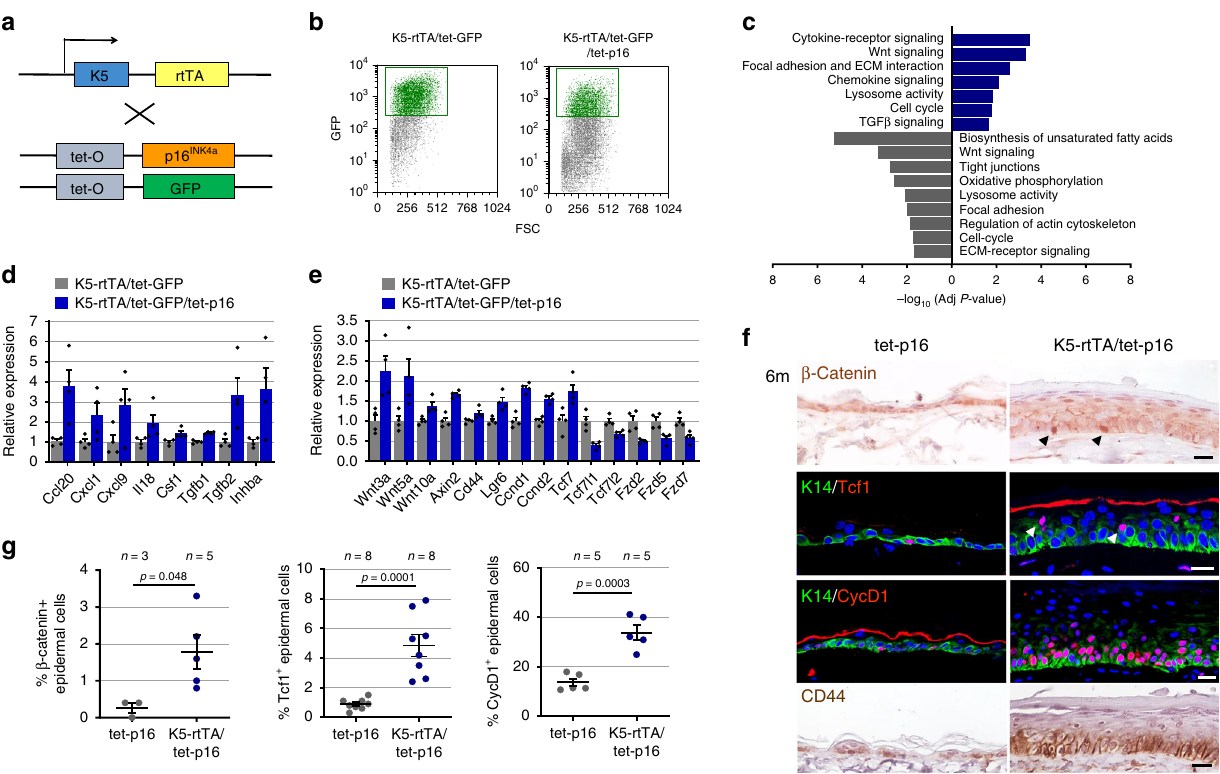
Fig. 4 p16 expression activates Wnt-pathway-associated genes. a Diagram of transgenic mouse lines crossed for co-induction of GFP and p16. b FACS plots showing GFP levels and gates used for isolation of GFP + epidermal cells from K5-rtTA/tet-GFP/tet-p16 (right) and control K5-rtTA/tet-GFP (left) mice, after 6 months of induction. Plots show the CD31 − /CD140a − /CD45 − cell fraction only. c Gene sets whose expression was preferentially upregulated (blue) or downregulated (grey) in GFP + cells from p16-expressing mice relative to GFP + cells from control mice. Values indicate – log 10 (adjusted P value) by hypergeometric test. d mRNA levels of genes encoding cytokines and genes associated with the TGF β pathway upregulated in p16-expressing GFP + cells, measured by mRNA-seq. Values were normalized to the mean expression levels in GFP + cells from control mice, de fi ned as 1. P < 0.05 for all genes, n = 4 samples per group, each pooled from 3 mice. e Relative mRNA levels of genes associated with the Wnt pathway in the same samples. P < 0.05 for all genes, n = 4 samples per group, each pooled from 3 mice. f Skin sections from K5-rtTA/tet-p16 and control tet-p16 mice treated with dox for 6 months stained for β -Catenin, Tcf1, Cyclin D1 or CD44. Arrowheads indicate representative positively stained cells. g Percentages of nuclear β -catenin + , Tcf1 + , and CyclinD1 + IFE cells in control and p16-expressing mice after 6 months of induction, as scored visually from images. P values calculated by t test. All graphs indicate mean across mice ± S.E.M. Scale bars — 20 μ